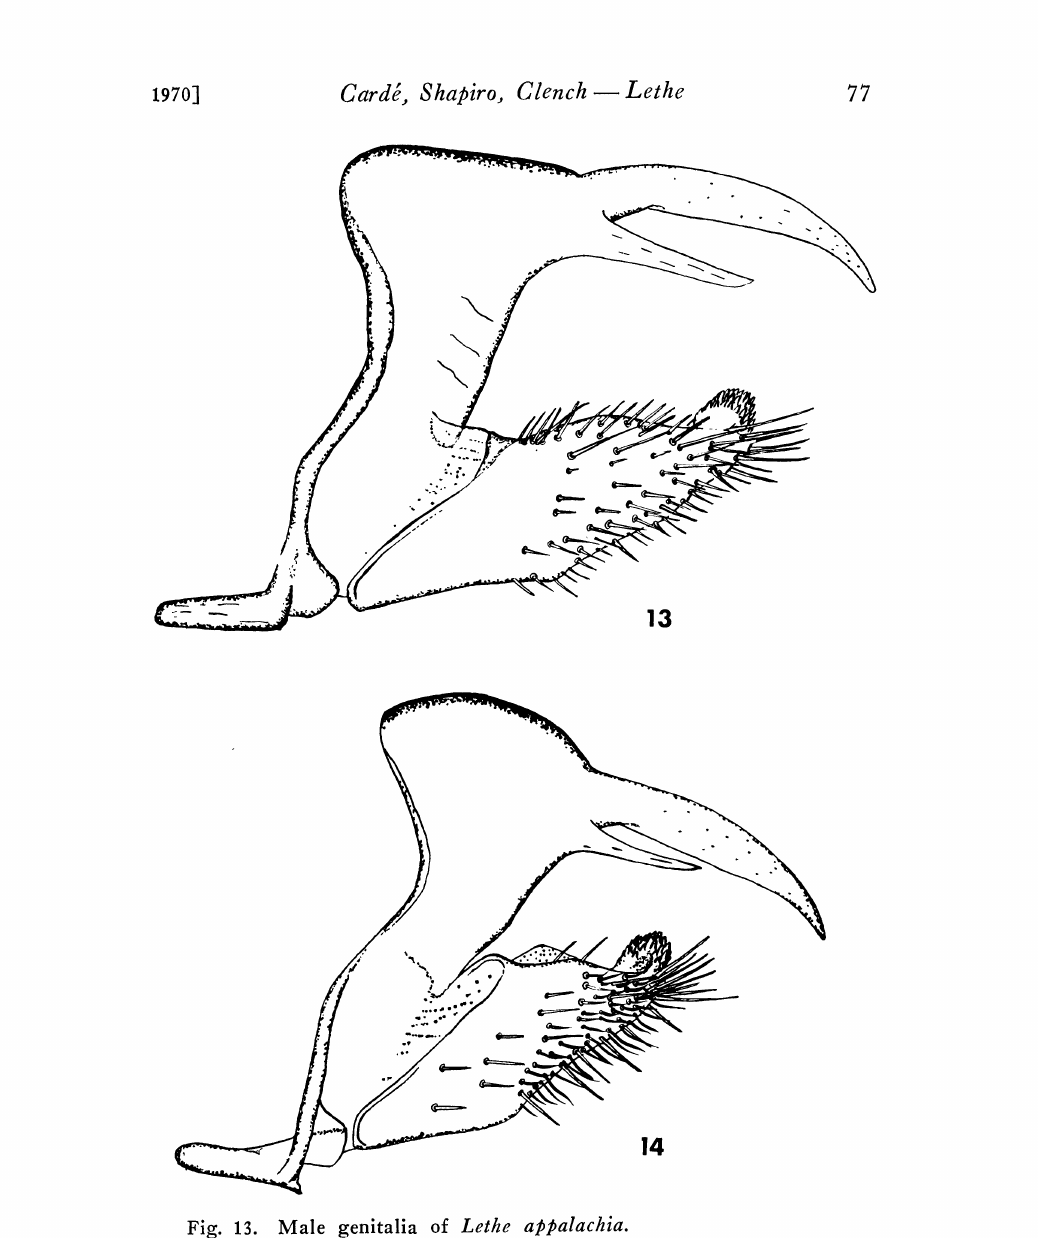
Fig. 13. Male genitalia of Lethe al)lalachia. Fig. 14. Male genitalia of Lethe